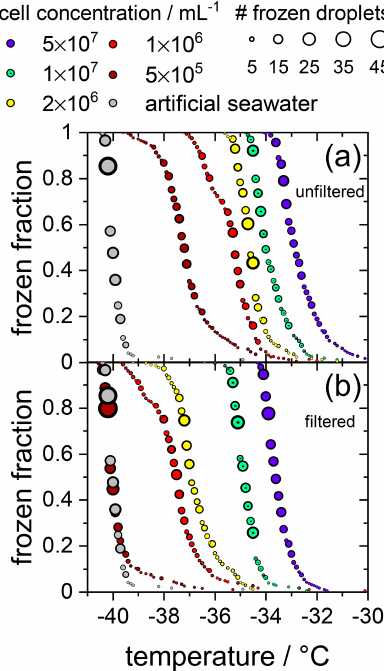
Figure 2. Cumulative fraction of frozen droplets as a function of temperature for different F. cylindrus cell concentrations (coloured circles) and pure artificial seawater (grey circles) as a reference. The size of the circles indicates the number of droplets frozen within the same temperature interval (0.1 ◦ C). Every data set combines three individual measurements each containing between 45 and 70 droplets. (a) Frozen fraction curves for the five F. cylindrus sam- ples, containing mostly whole diatoms and, probably, some frag- ments. (b) Freezing temperatures of the filtered (0.22µm) samples. These samples, thus, contain no whole cells but fragments, in ad- dition to proteins and other soluble components. Note that the con- centrations refer to the diatom concentrations before filtration. The seawater reference (grey circles) is the same in both panels.